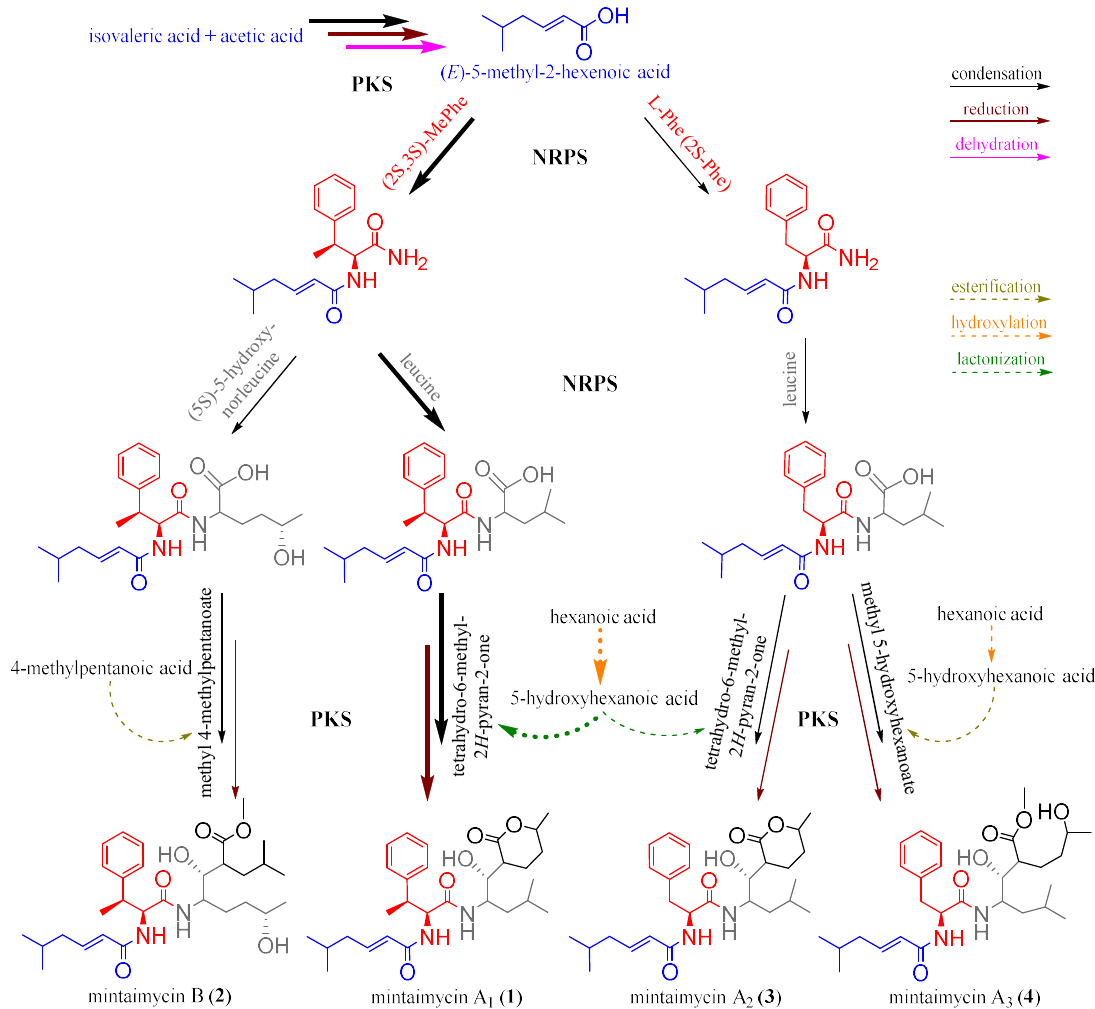
Figure 4. The plausible pathway for mintaimycin biosynthesis.